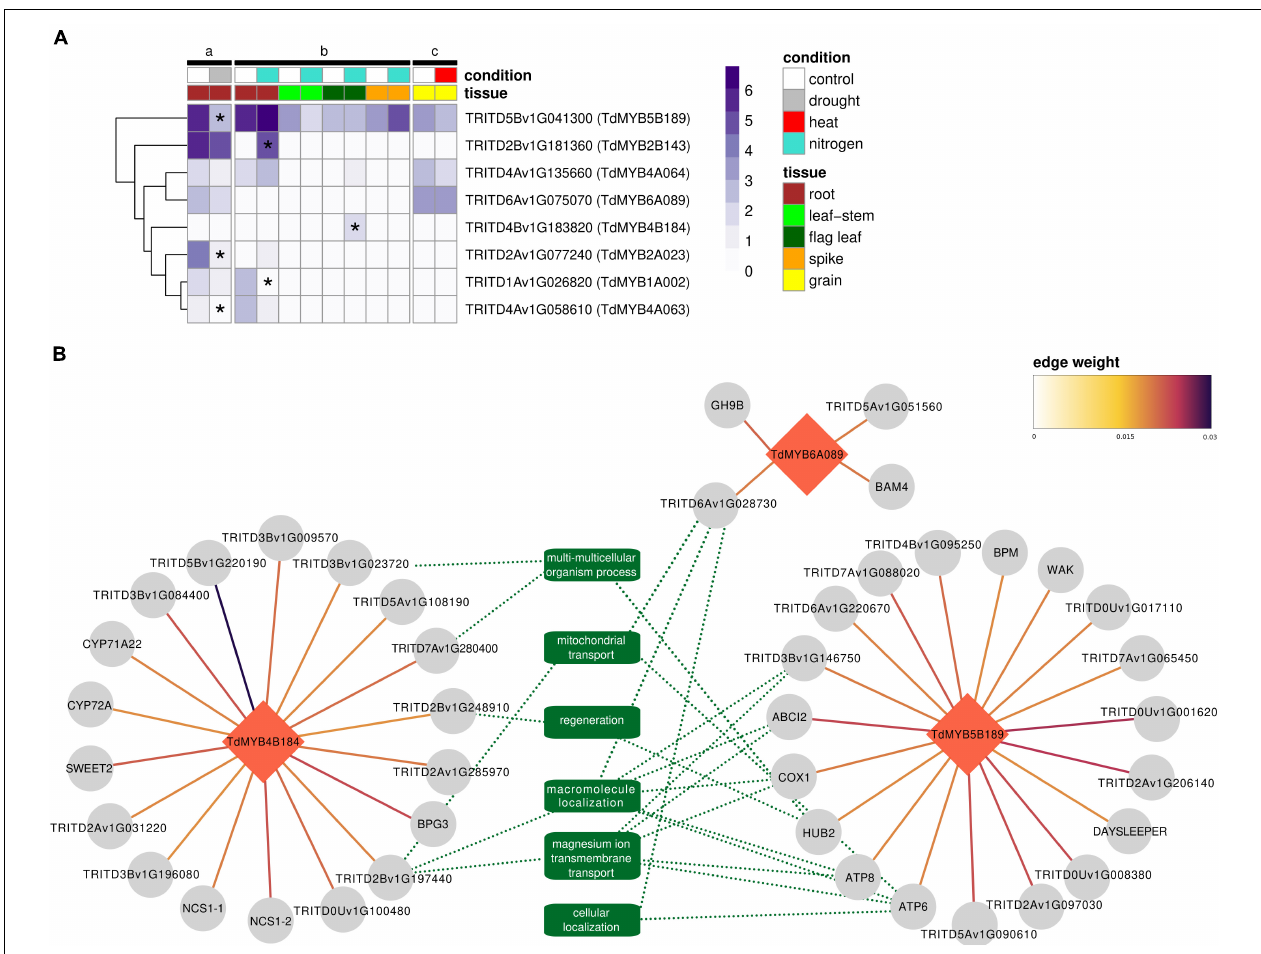
FIGURE 6 | Gene expression and regulatory interactions in public transcriptomic data on abiotic stresses. (A) Expression profiles of the eight TdR2R3-MYB genes selected for qPCR experiments across a subset of the public transcriptomic studies (a-c) listed in Supplementary Table 5 for which ≥ 3 replicates were available. Expression values are given as log 2 (TPM + 1) of the average of the biological replicates per condition per study. Differentially expressed genes are marked with an asterisk. (B) GENIE3 regulatory network of TdMYB5B189 , TdMYB4B184 , and TdMYB6A089 TFs (red diamonds). Target genes are depicted with gray circles. Links between genes show edge weight. Green dotted lines show connections with related REVIGO-summarized biological processes in common across regulatory clusters (minimum two). Where available, gene name (from Arabidopsis thaliana ortholog) in place of gene ID is